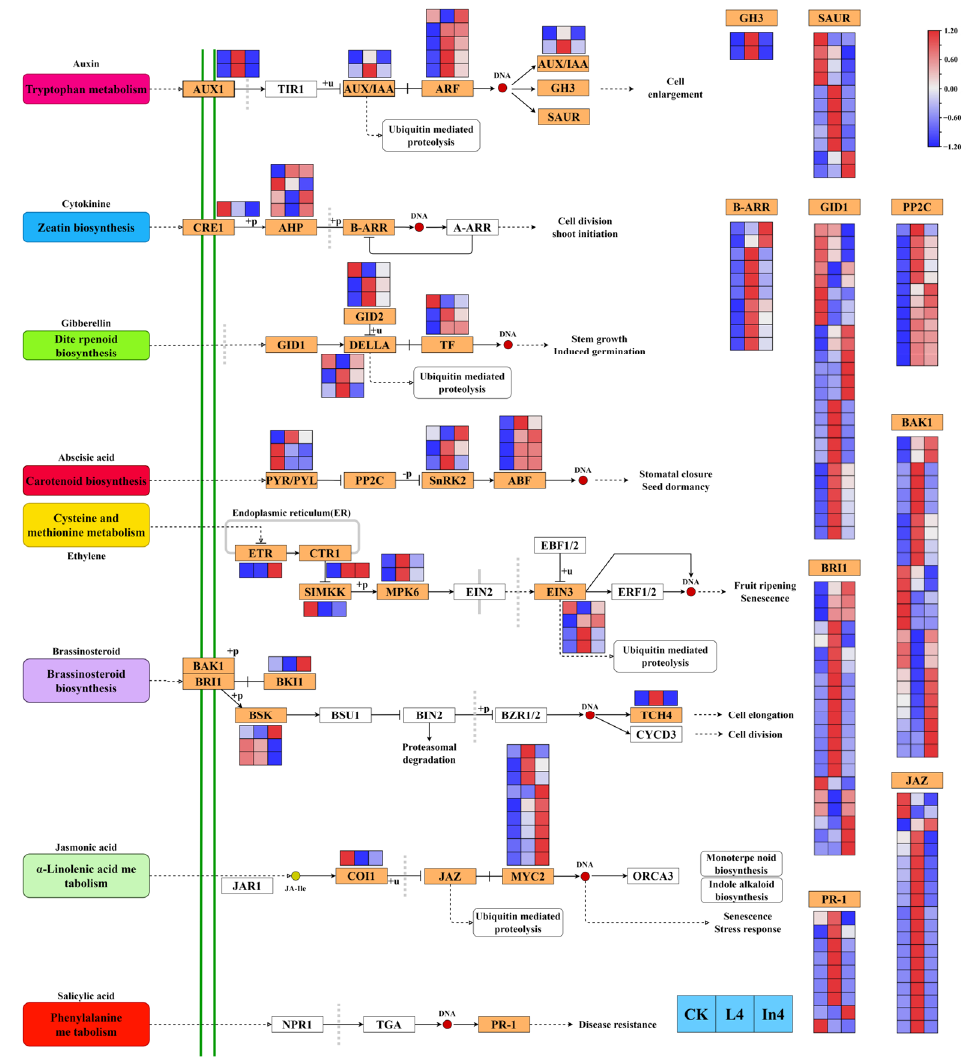
Figure 9. Analysis of DEGs related to phytohormone signaling pathways. The gene expression levels in the three samples are shown in different columns in the colored boxes, and different rows represent different genes. CK: Control. L4: Supplementary LED for 4 h. In4: Supplementary Incandescent lamp for 4 h. The color scale from Min (blue) to Max (red) refers to the expression value from low to high.